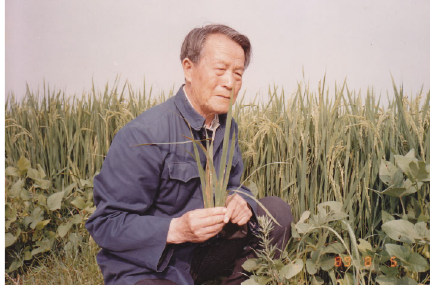
Figure 2. Prof. Duan was working on collection and investigation of rice blast.